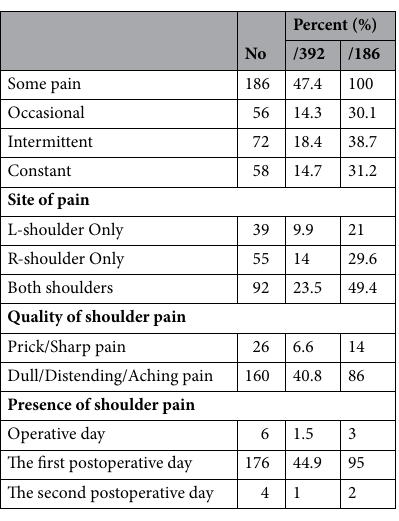
Table 1. Basic characteristics of the patients’ shoudler pain (n = 392). Values are presented as number or